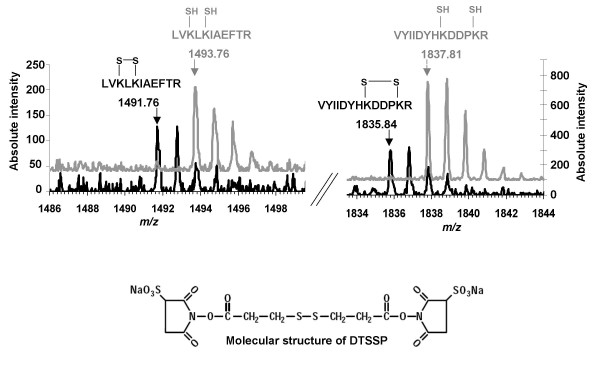
DTSSP cross-linked peptides identified by MALDI-TOF mass spectrometry. Protein samples were mixed with DTSSP for 30 min at room temperature at a molar ratio 1:20 (protein:DTSSP). They were then subjected to trypsin proteolysis. Masses of peptides treated with DTT (grey spectrum) or untreated (black spectrum) were measured by MALDI-TOF mass spectrometry. Peptide sequences are indicated and DTSSP cross-links or DTSSP moieties arising from DTT treatment are depicted schematically. Monoisotopic masses of protonated peptides [MH+] are theoretically: 1491.807 amu and 1493.822 amu for LVKLKIAEFTR [21-31] cross-linked with one DTSSP molecule (untreated (C68H115N16O17S2) and DTT-reduced (C68H117N16O17S2), respectively), 1835.846 amu and 1837.862 amu for VYIIDYHKDDPKR [3-15] cross-linked with one DTSSP molecule (untreated (C82H123N20O24S2) and DTT-reduced (C82H125N20O24S2), respectively).